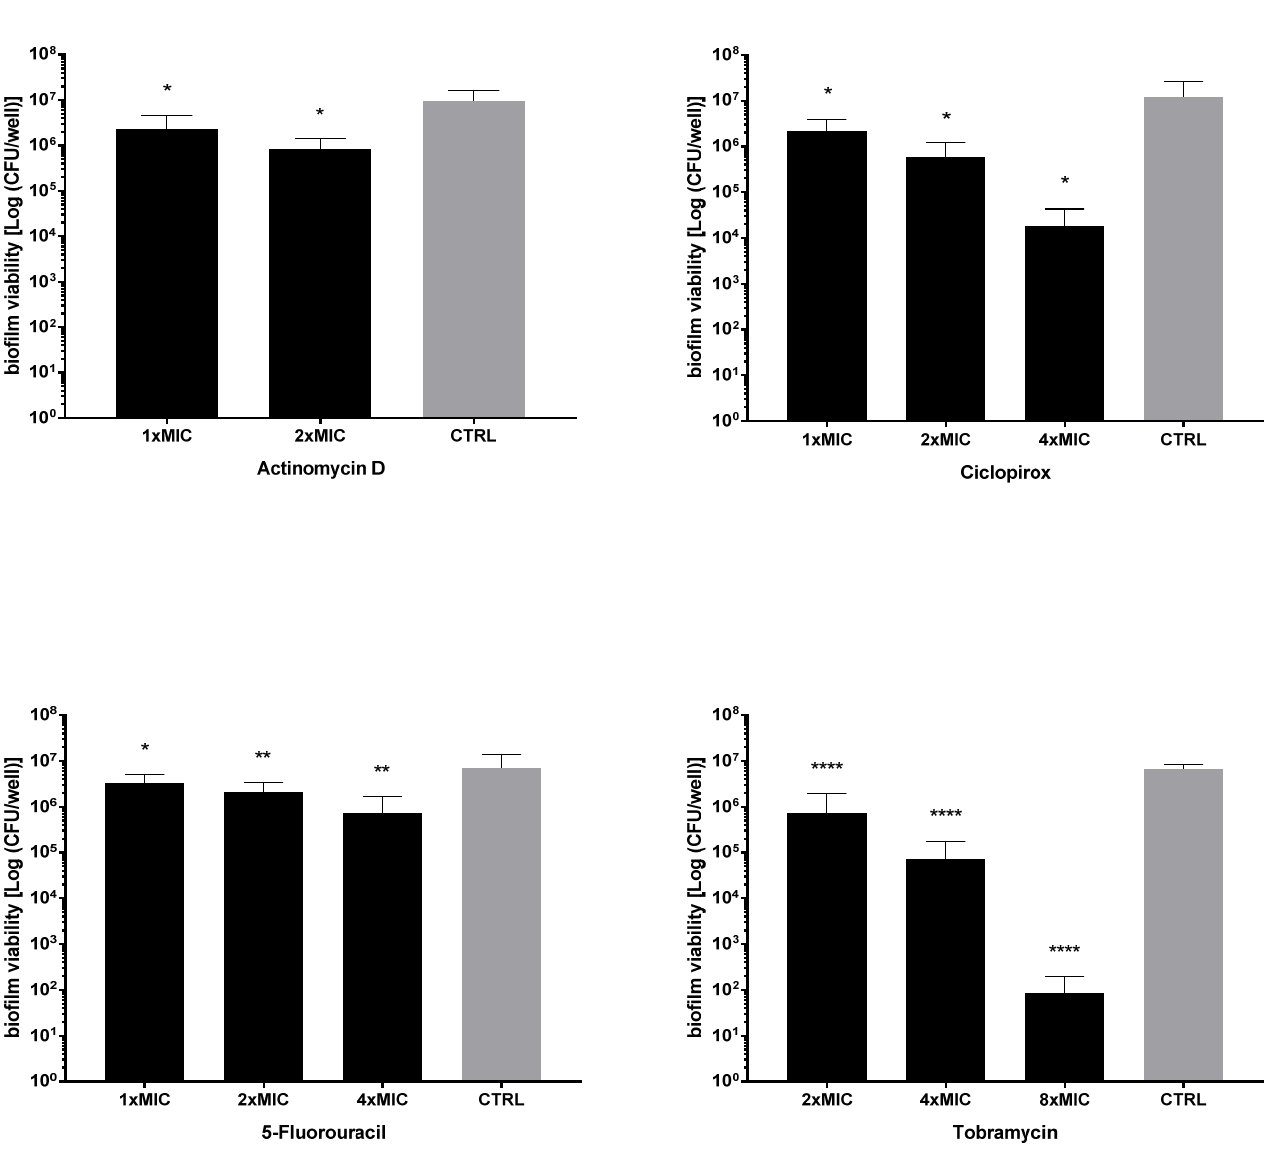
Figure 7. Killing activity against preformed biofilms by P. aeruginosa PaPh32. The efficacy of acti- nomycin D, ciclopirox, and 5-fluorouracil on the viability of 24 h mature biofilms by P. aeruginosa PaPh32 was assessed, comparatively to tobramycin, using cell viable count assay. Each drug was tested at multiples of MIC value. Results are expressed as mean + SD of the residual biofilm viability [Log (CFU/well)] after 24 h of exposure. Control samples (CTRL) were not exposed to the drug. Statistical significance at ordinary one-way ANOVA + Holm–Sidak’s multiple comparisons post-test: * p < 0.05, ** p < 0.01, **** p < 0.0001 vs. CTRL.